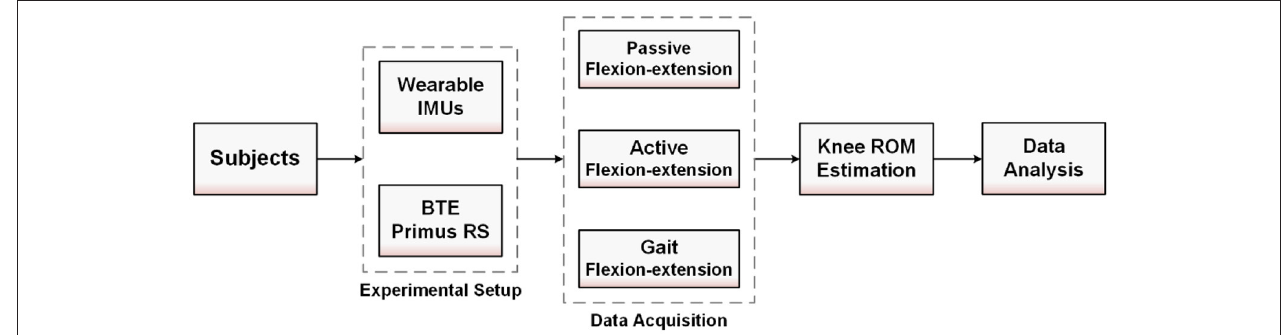
FIGURE 1 | The flowchart and objectives of this experiment.